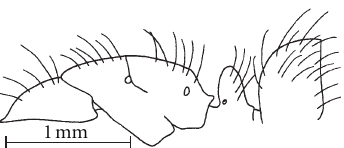
Figure 1: Mesosoma, petiole, and first gastral tergum of a minor worker of C. reburrus (Napo, Ecuador).